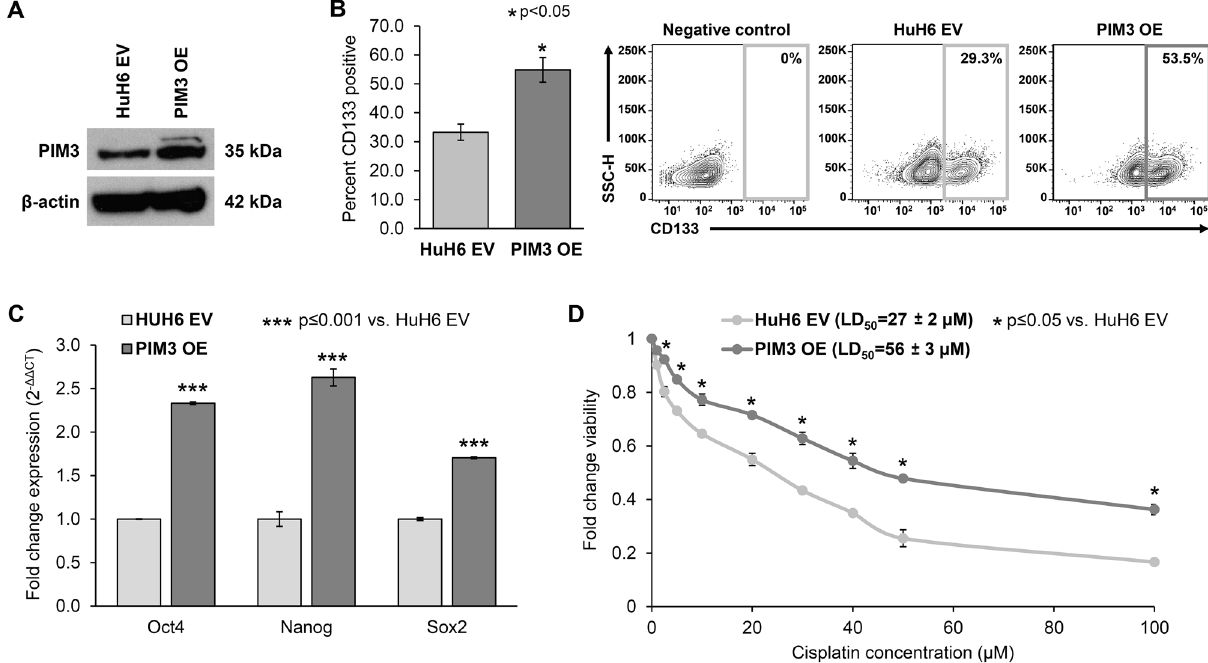
Figure 7. Overexpression of PIM3 in hepatoblastoma cells results in increased stem cell-like cancer cell (SCLCC) phenotype and decreased cisplatin sensitivity. HuH6 cells were stably transfected with a pcDNA3.1/ V5-HisC-based expression vector for PIM3 overexpression (PIM3 OE) or an empty vector (EV) control. ( A ) Immunoblotting of whole cell lysates verified PIM3 overexpression. β-actin was used to confirm equal protein loading. ( B ) CD133 cell surface expression was evaluated by FACS in HuH6 EV and PIM3 OE cells and reported as percent CD133 expression ± SEM. CD133 expression was increased significantly in the PIM3 OE cells. Representative contour plots are shown to the right of the graph. ( C ) Quantitative real-time PCR was utilized to assess the mRNA abundance of Oct4, Nanog, and Sox2 in HuH6 EV and PIM3 OE cells. Relative abundance of mRNA was calculated using the ΔΔCt method and reported as mean ± SEM of three biologic replicate experiments. PIM3 OE cells had significantly increased abundance of all three stem cell markers compared to HuH6 EV cells (p < 0.001), further indicating an increase in the SCLCC phenotype following overexpression of PIM3. ( D ) The effect of PIM3 OE on hepatoblastoma cell viability following treatment with cisplatin was evaluated with alamarBlue assay. HUH6 EV and PIM3 OE cells were treated with increasing concentrations of cisplatin (0–100 µM) for 72 h and viability measured. PIM3 OE cells were significantly less sensitive to cisplatin than HuH6 EV cells, indicating that PIM3 contributes to cisplatin